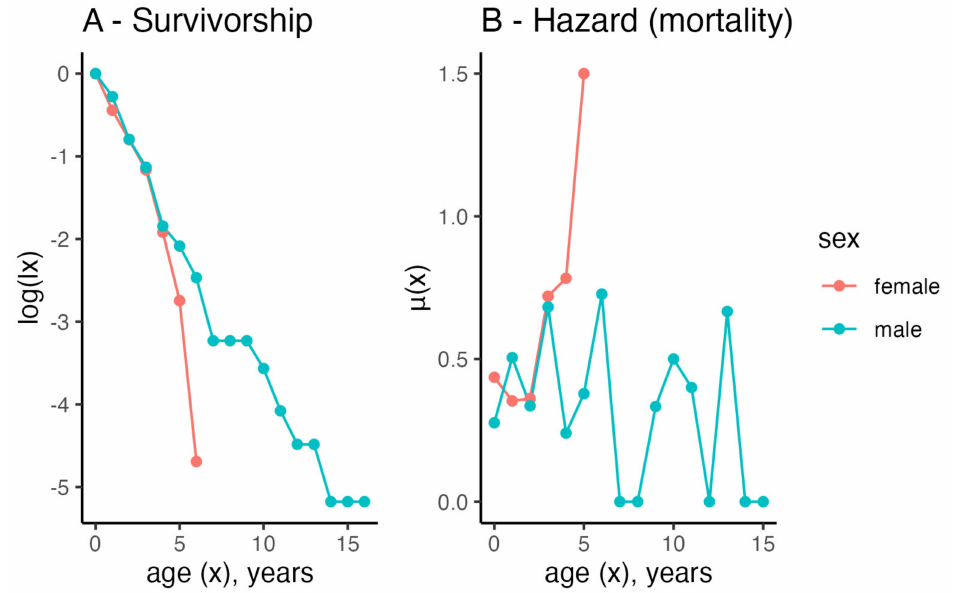
Figure 6. Empirical survivorship curves ( A ) and mortality rates ( B ) for male and female hedgehogs, calculated using standard life table